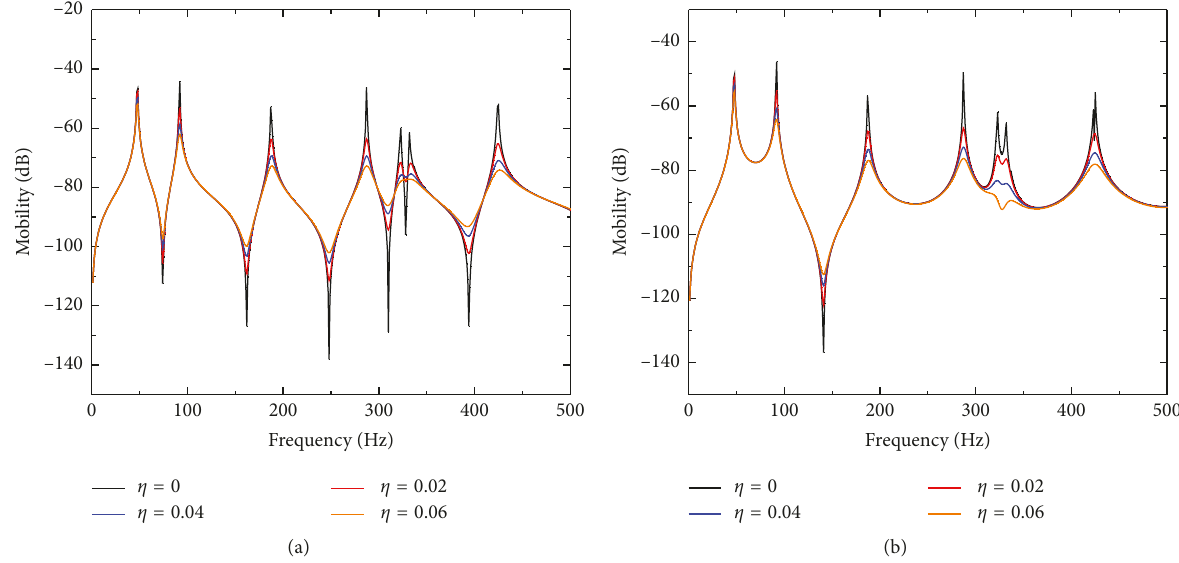
Figure 10: Damping effects on the mobility characteristics of a rectangular plates stiffened by three y -wise evenly distributed beams ( p (a) Point A (1m, 0.5m). (b) Point B (0.5m,